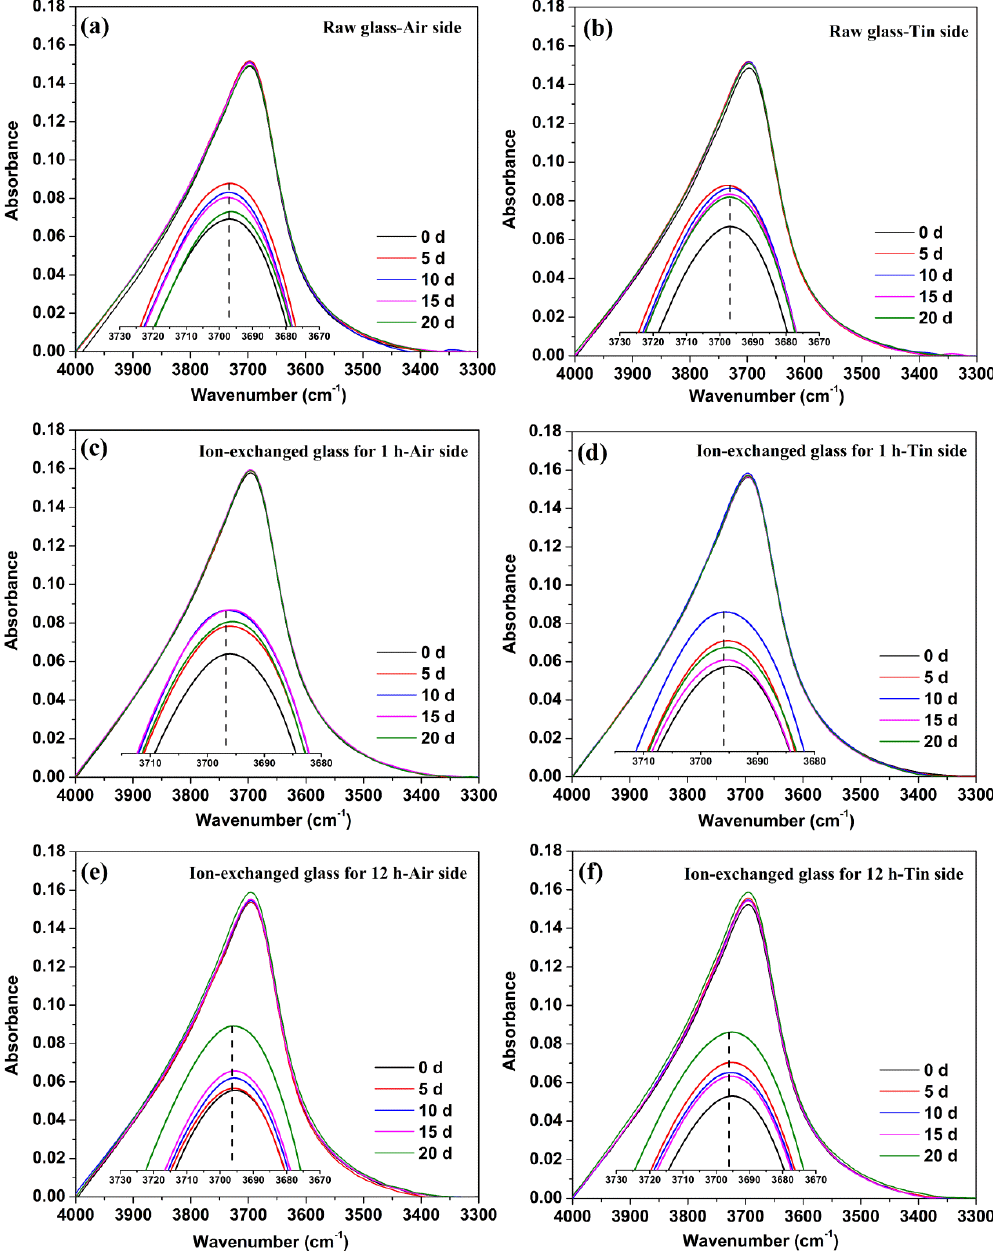
Figure 5. IR spectra of 3300–4000 cm −1 on the air side ( a ) and tin side ( b ) of the raw glass, on the air side ( c ) and tin side ( d ) of the ion-exchanged glass for 1 h, and on the air side ( e ) and tin side ( f ) of the ion-exchanged glass for 12 h. The peaks are enlarged and shown as the insets.